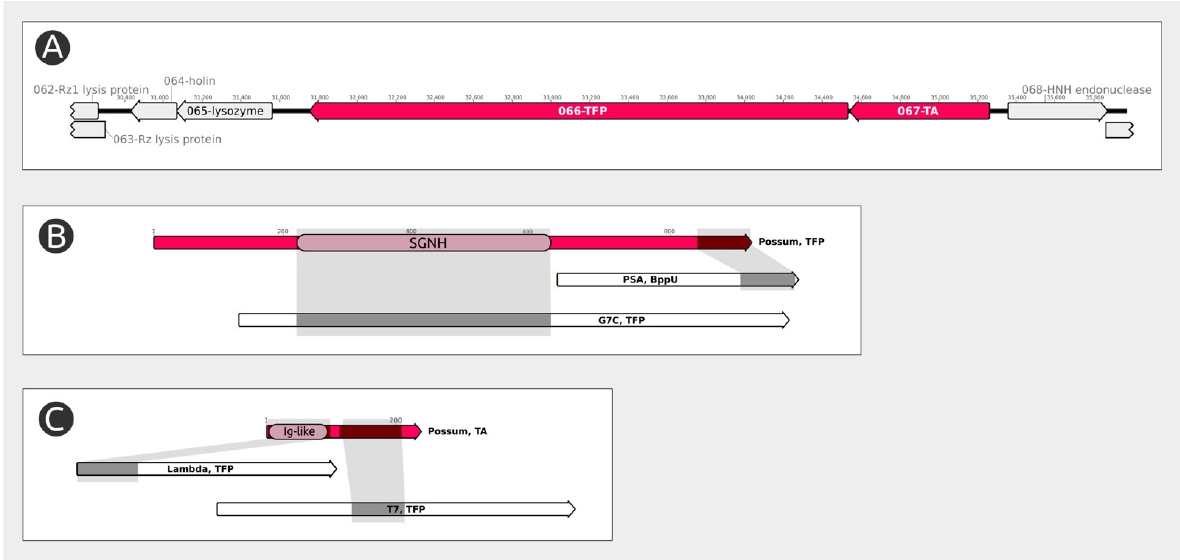
Figure 4. ( A ) The Pectobacterium phage Possum genomic map of the region containing the tail fiber genes. ( B ) Schematic representation of structural similarity between the Possum’s tail fiber protein 1 (gp66) and other phages’ proteins obtained with the HHpred HMM-HMM analysis. ( C ) Schematic